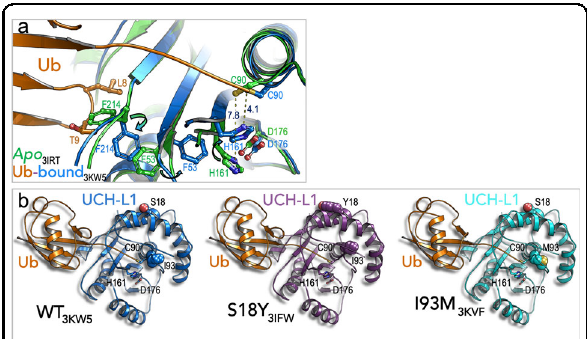
Fig. 5 Structures of wild type and Parkinson ’ s disease-associated variants of UCH-L1. a Superposition of the structures of wild-type apo and covalent bound ubiquitin to UCH-L1 is shown (PDB code 3KW5 93 ). Active site rearrangement and activation is due to ubiquitin binding. b Structures of the Parkinson ’ s disease variants, S18Y and I93M, are shown (PDB codes 3IFW and 3KVF) in comparison to the structure of wild-type UCH-L1 in complex with covalent